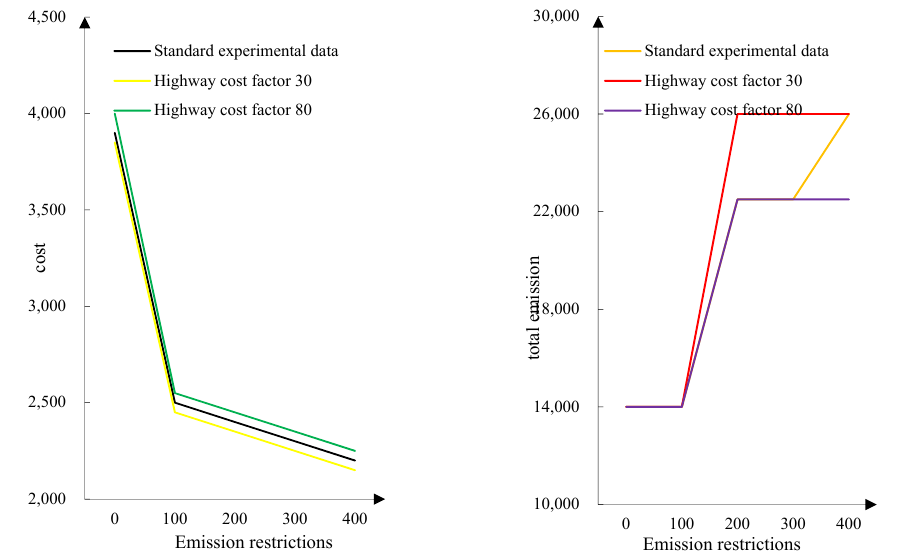
Figure 9. Impact on route emissions under different road cost factors.